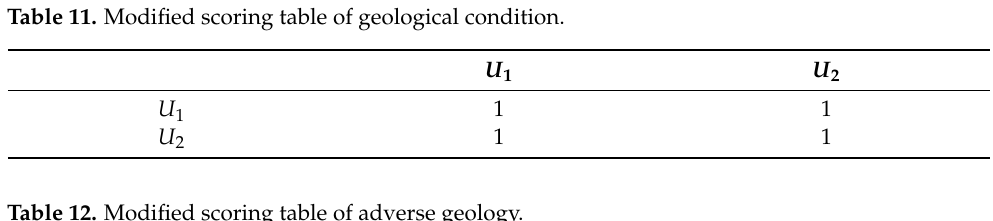
Table 12. Modified scoring table of adverse geology.